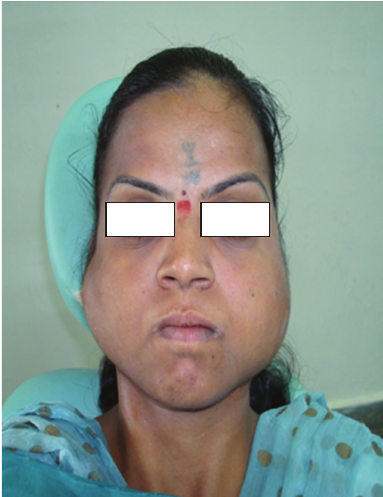
Figure 1: The figure shows frontal bossing, broad nasal bridge, hypertelorism, and mandibular prognathism.